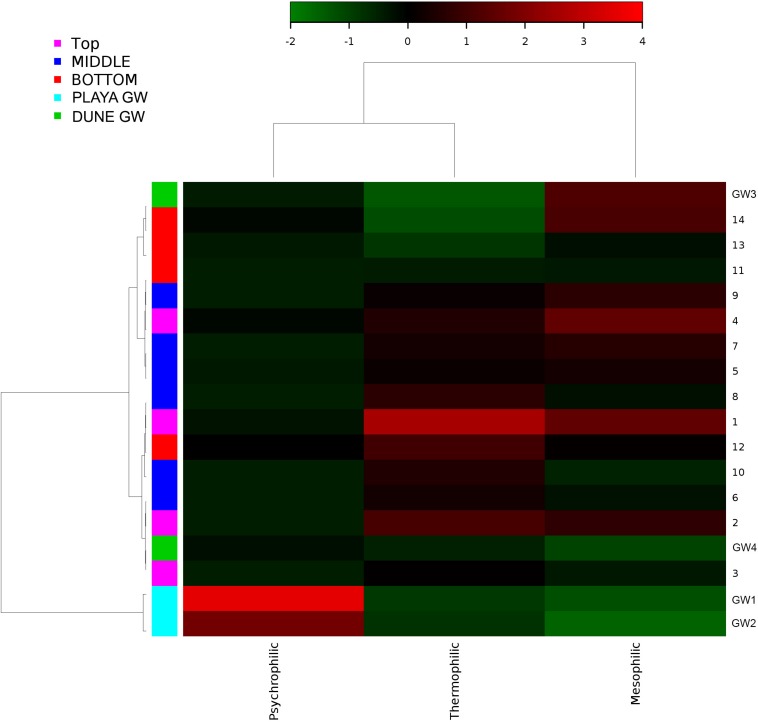
Heatmap of bacterial temperature adaptation inferences constructed from 16S rRNA-based taxonomic identities. The color scale represents relative intensity of each metabolic pathway, with red being the highest and the green the lowest.